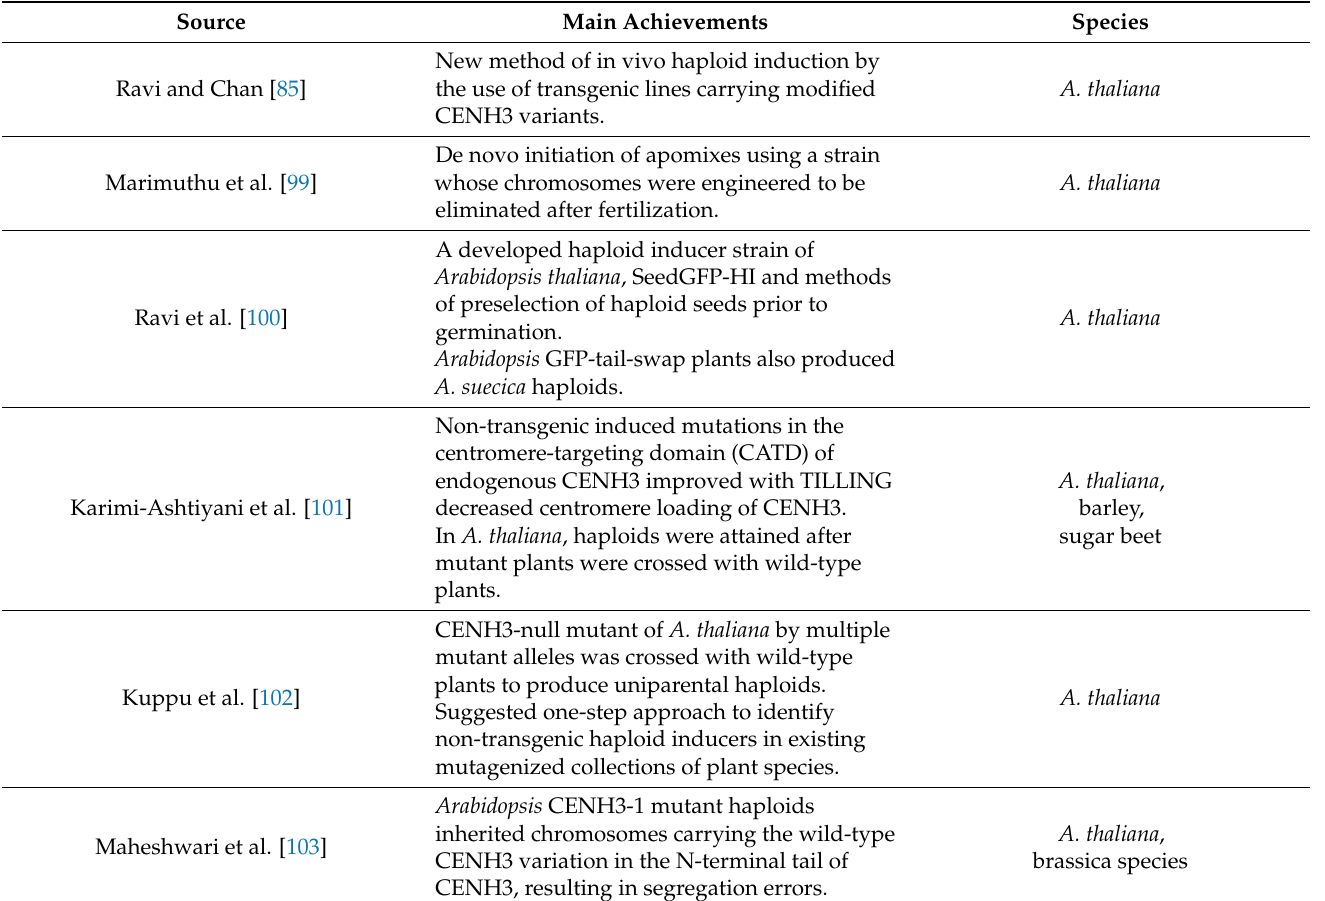
Table 2. Main achievements in haploid induction through centromere